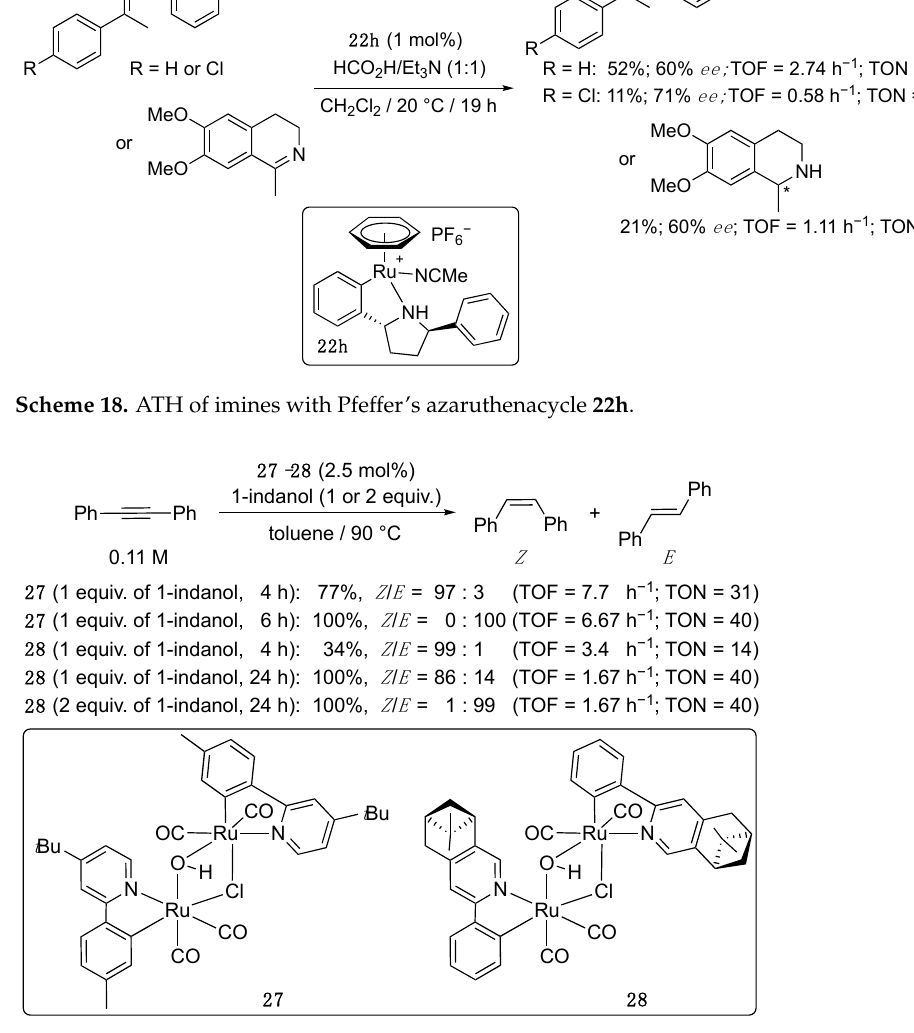
Scheme 19. Base-free TH of diphenylacetylene to Z - and/or E -stilbene catalyzed by µ -chlorido, µ - hydroxy-bridged dicarbonyl ruthenacycles 27 and 28